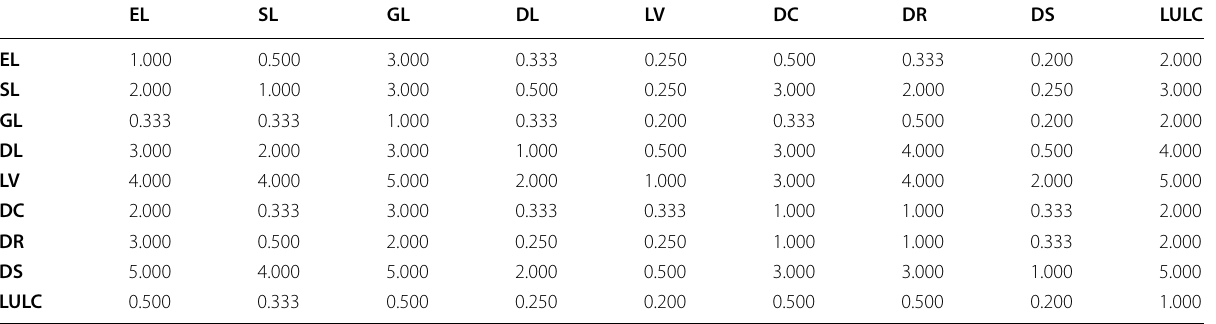
Where, EL, SL, GL, DL, LV, DC, DR, DS and LULC denotes elevation, slope, geology, Distance from lineament, land value, Distance from river & canal, Distance from road, Distance from residence and land use land cover respectively Source: Computed by the author Table 6 Normalized pair-wise comparison matrix of nine thematic layers for suitable landfill site selection